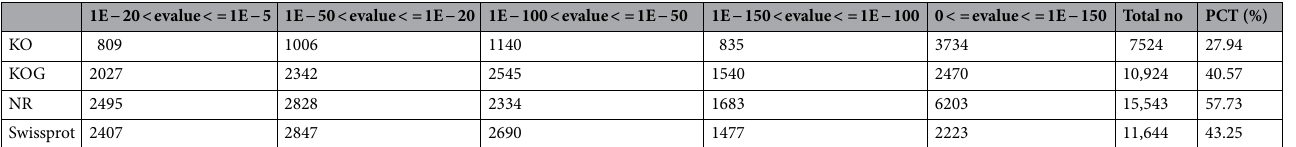
Table 3. Unigenes annotated in different databases. NR NCBI non-redundant protein sequences, Swissprot A manually annotated and reviewed protein sequence database, KO KEGG Orthology, KOG Clusters of Orthologous Groups of proteins, Total no. total number of annotated unigenes, PCT ( % ) percentage